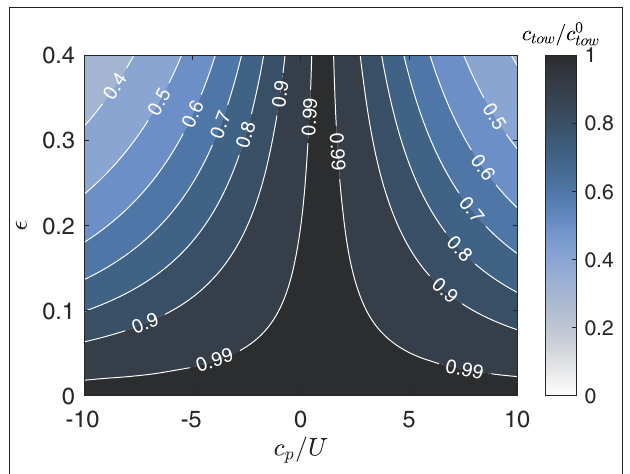
FIGURE 7 | Contour plot of relative concentration calculated using total arc length in waves vs. no waves c tow / c 0 tow , plotted as a function of wave steepness ǫ and relative wave speed c p / U . The values were calculated using Equations (18) and (19).